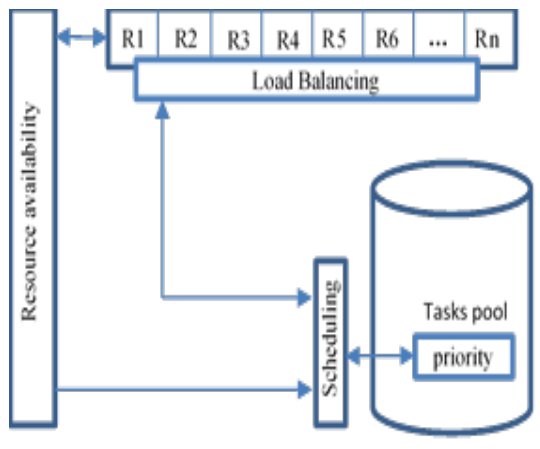
Figure 7. Scheduling optimization supporting.